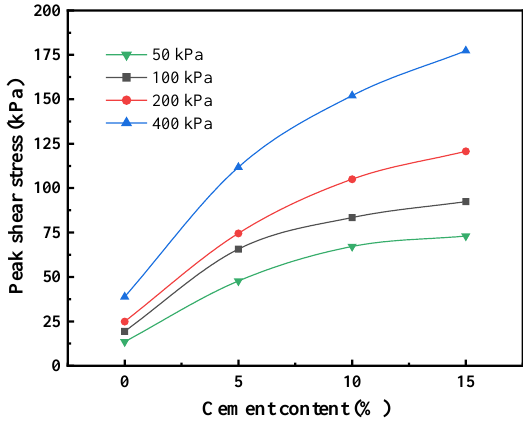
Figure 5. Relation between peak shear stress and grouting parameters.